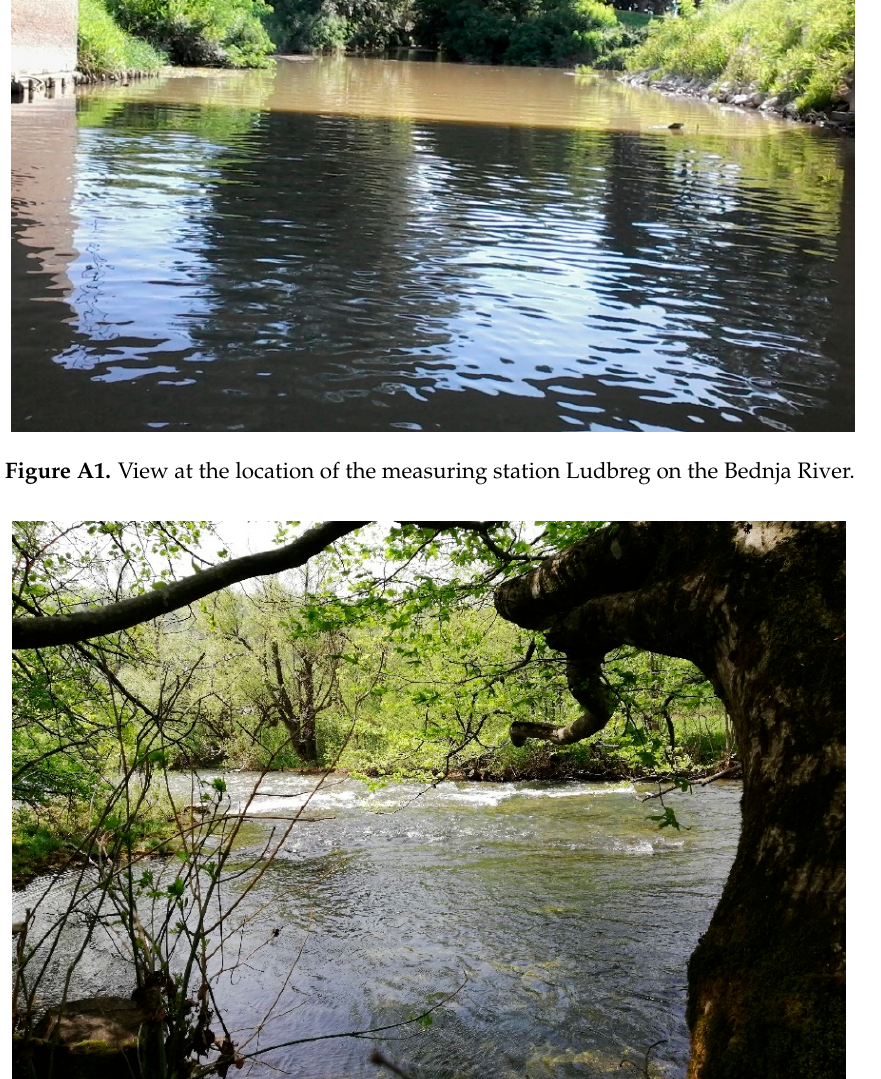
Figure A3. View at the location of the measuring station Motovun on the Mirna River.